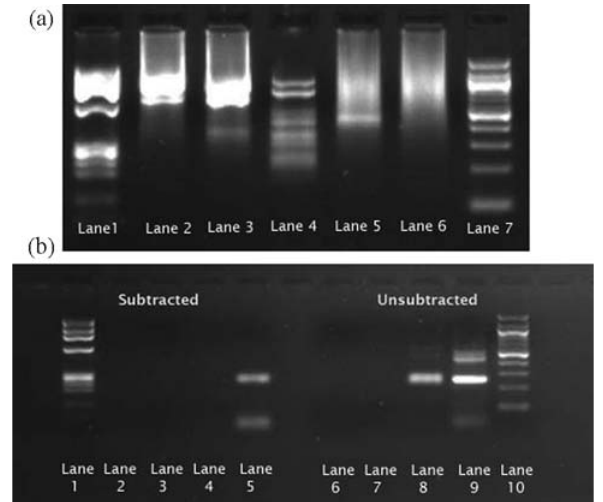
Figure 1 - (a) Secondary PCR products after subtraction. Lane 1 - ØX174/HaeIII digested marker; lane 2 - Control subtracted sample from kit; lane 3 - Experimental subtracted control cDNA; lane 4 - Experimental unsubtractedcontrol;lane5-Experimentalsubtractedsample;lane6-Ex- perimental unsubtracted sample; lane 7-100 bp ladder; (b) PCR analysis of subtraction efficiency using actin primers. PCR was performed on sub - Figure 2 - Multiple Sequence Alignment. Sequence alignment of metallo- tracted and unsubtracted samples using equal quantity (50 ng) of cDNA thionein type-2 of Piper nigrum to type-2 metallothioneins from other from each sample. Lane 1 - ØX174/HaeIII digested marker; lanes 2 and plant sources. Sequences were aligned by the CLUSTALW program. 6-18 cycles; lane 3 and 7-23 cycles; lanes 4 and 8-28 cycles; lanes 5 and Conserved CXC amino acids in the 3’ domain are 9-33 cycles; lane 10-100 bp marker. Table 1 - Real-Time RT-PCR analysis of metallothionein type-2 transcript. Relative quantification study was done to calculate the fold expression of metallothionein in root and leaf. Analysis was performed with cDNAs from root (avgCt = 23.592) and leaf (avgCt = 16.649). Metallothionein transcript levels are normalized to β -actin levels using the formula dC T = C T (metallothionein) - C T (actin) where avgCt of actin in root and leaf is (C T = 21.570) and (C T = 21.657) respectively.